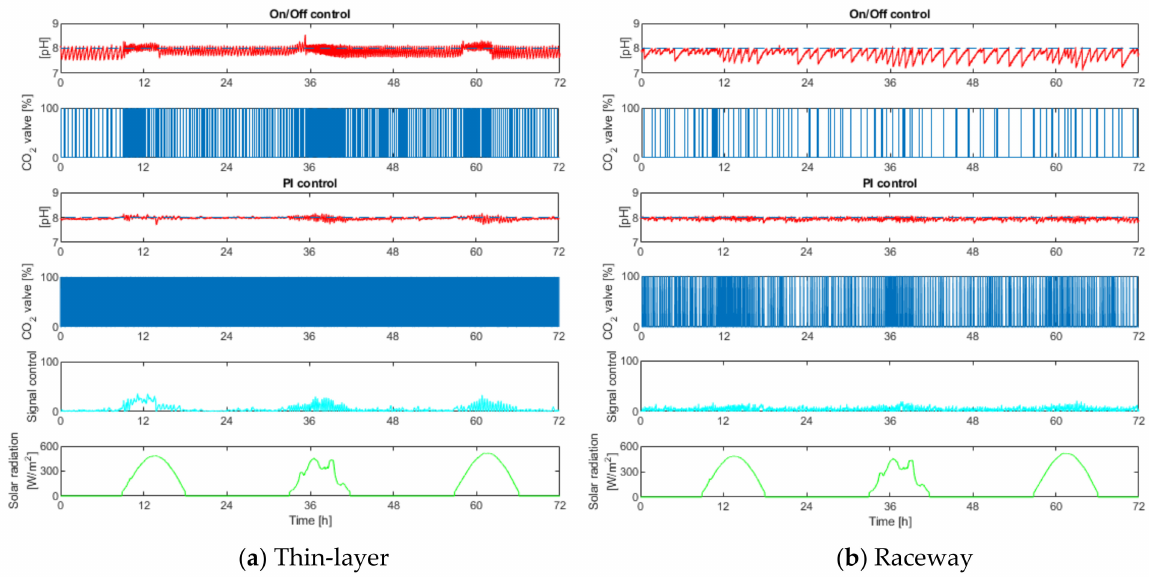
Figure 8. Results of the On/Off control and PI control architectures operated all day, in thin-layer ( a ) and raceway ( b ) reactors. First graphs represent the evolution of the pH with On/Off controller (continuous red line), and the set-point established (dashed blue line). Seconds graphs represent the CO 2 valve state of On/Off control, PWM signal. Third graphs represent the evolution of the pH with PI controller (continuous red line), and the set-point established (dashed blue line). Fourth graphs represent the CO 2 valve state of PI control, PWM signal. Fifth graphs represent the control signal by PI control. Sixth graphs represent global